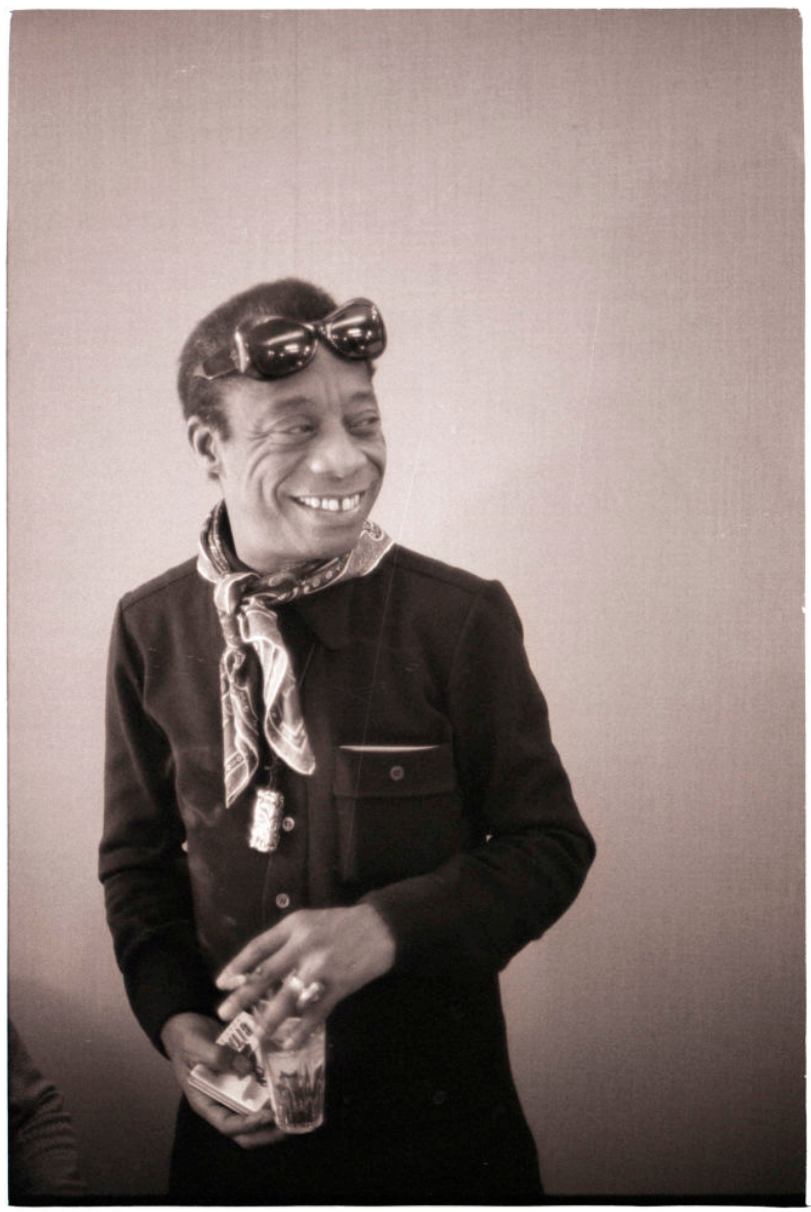
Figure 3. Photo by Sophie Bassouls/Sygma via Getty Images.